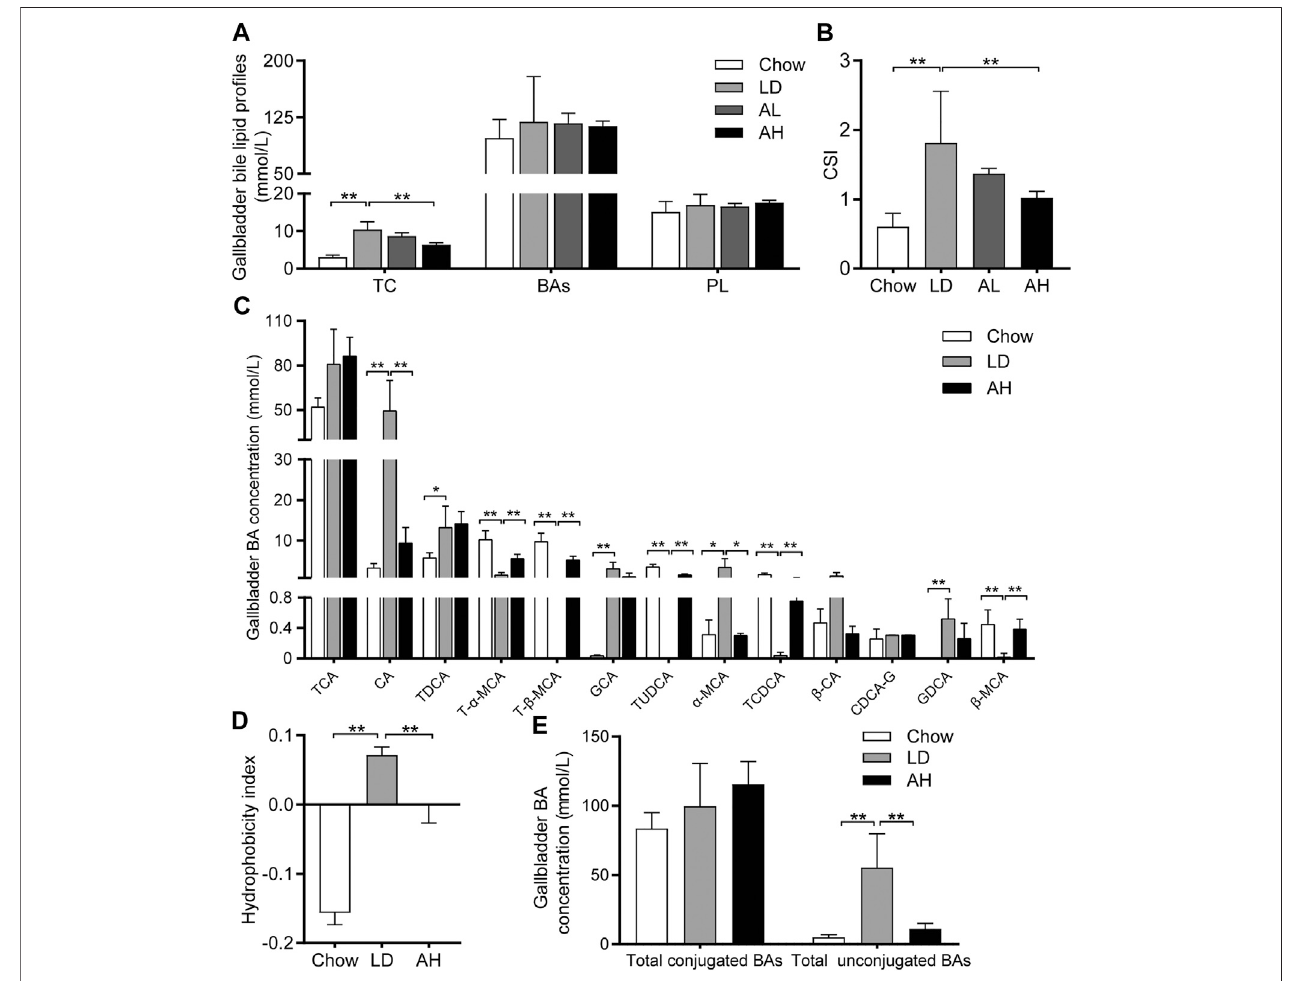
FIGURE 2 | Biliary Cholesterol Saturation Index (CSI) and Hydrophobicity Index (HI) of bile acids (BAs) in gallbladder bile. (A) Total cholesterol (TC), BAs and phospholipids (PL) ( n (cid:2) 8 – 10). (B) CSI (n (cid:2) 8 – 10). (C) Analysis of BA species ( n (cid:2) 6). Top-13 most abundant BA species are shown. (D) HI of BAs ( n (cid:2) 6). (E) Total conjugated BAs and unconjugated BAs ( n (cid:2) 6). Data are the mean ± SD, * p < 0.05, ** p < 0.01. Chow, chow diet; LD, lithogenic diet; AL, low-dose APS; AH, high- dose APS.